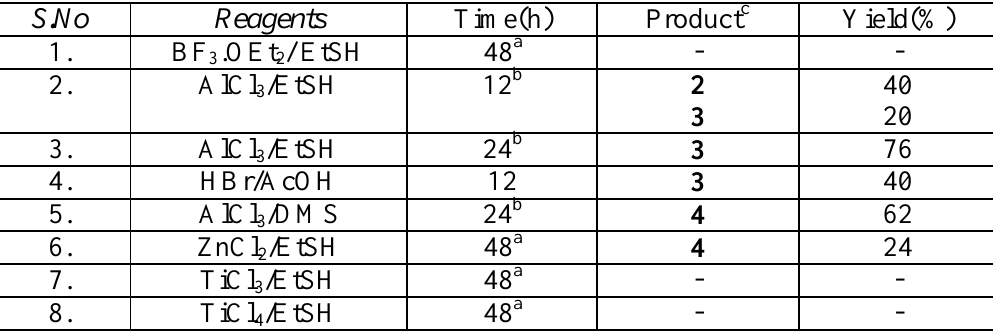
Table 1. Reactions of